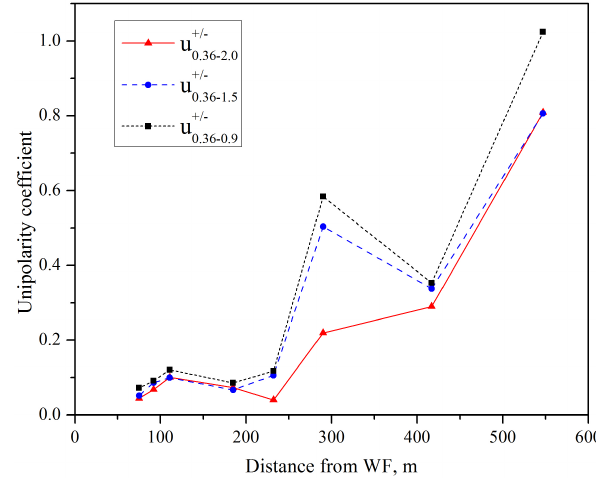
± ) for 3 different ion sizes versus distance measured at the Krimml WF, orographic right side.